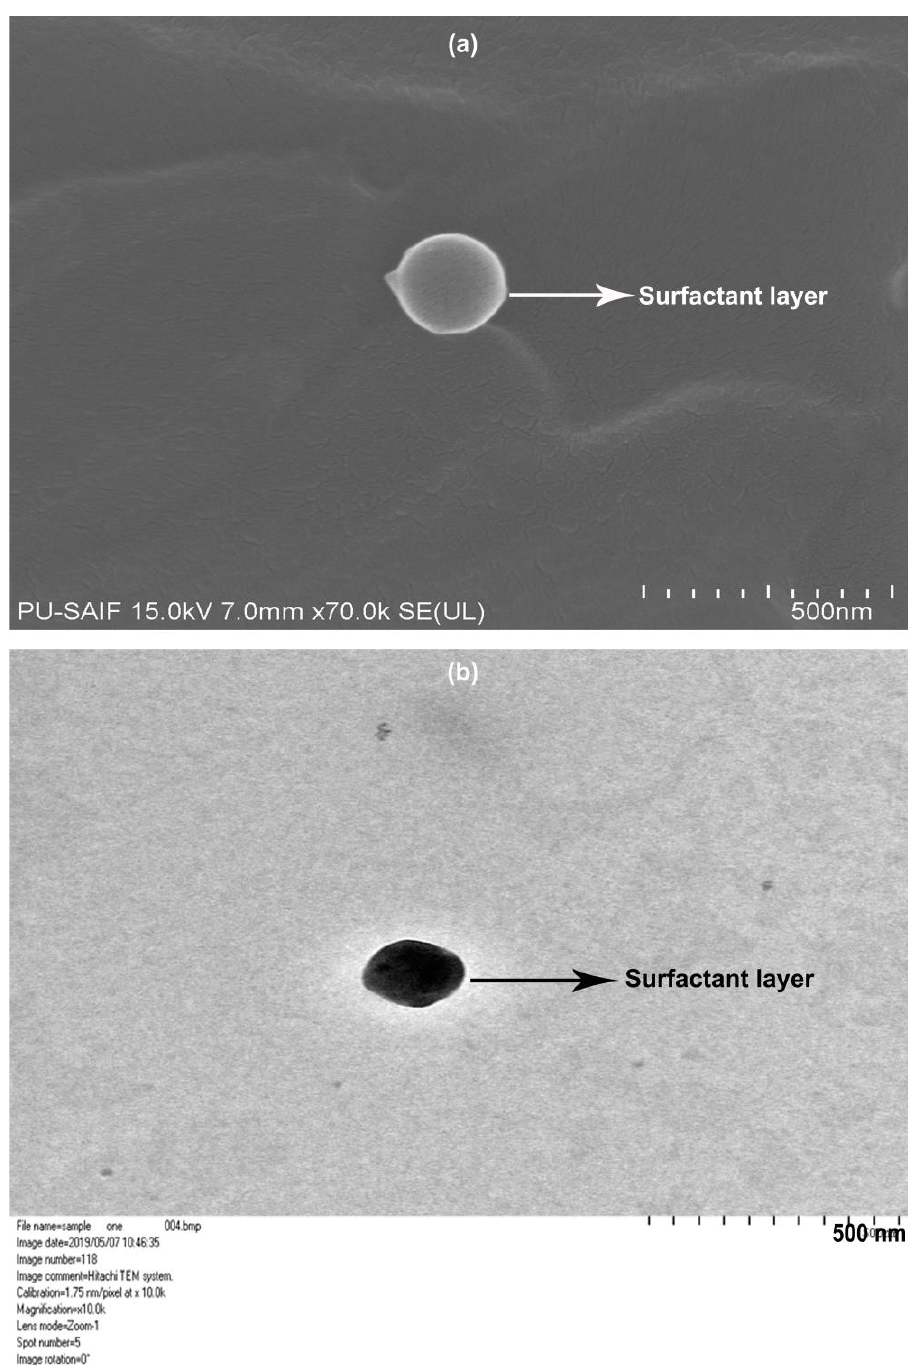
Figure 3. ( a ) FESEM image of the CSLNs (70,000 × ), ( b ) TEM image of the CSLNs (10,000 ×